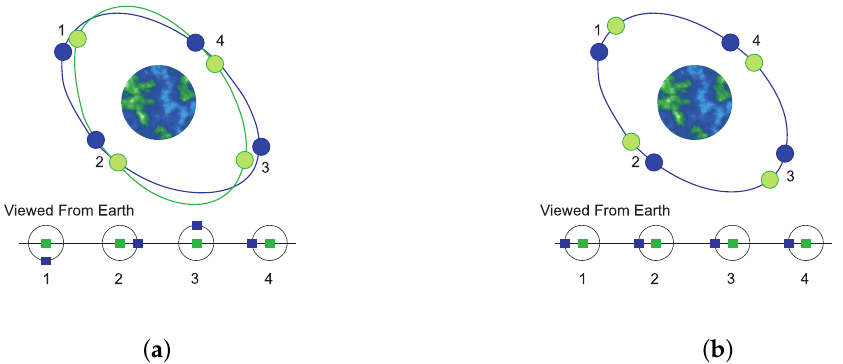
Figure 2. Configurations of satellite orbits. ( a ) Projected circular orbit. ( b ) Along-track orbit. Substituting the values c 1 = c 2 = r dpc , c 3 = 0 into equations (28), one obtains